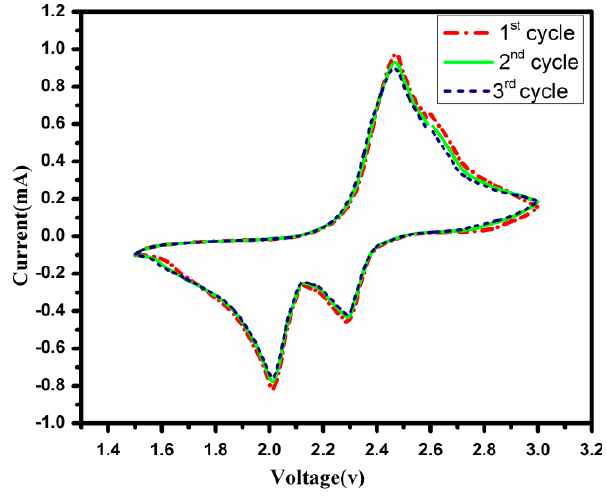
Figure 8. Voltammograms of sublimed sulfur / post-treated sepiolite / PAni) composite in the potential window from 1.5 to 3.0 V (verses Li + /Li).